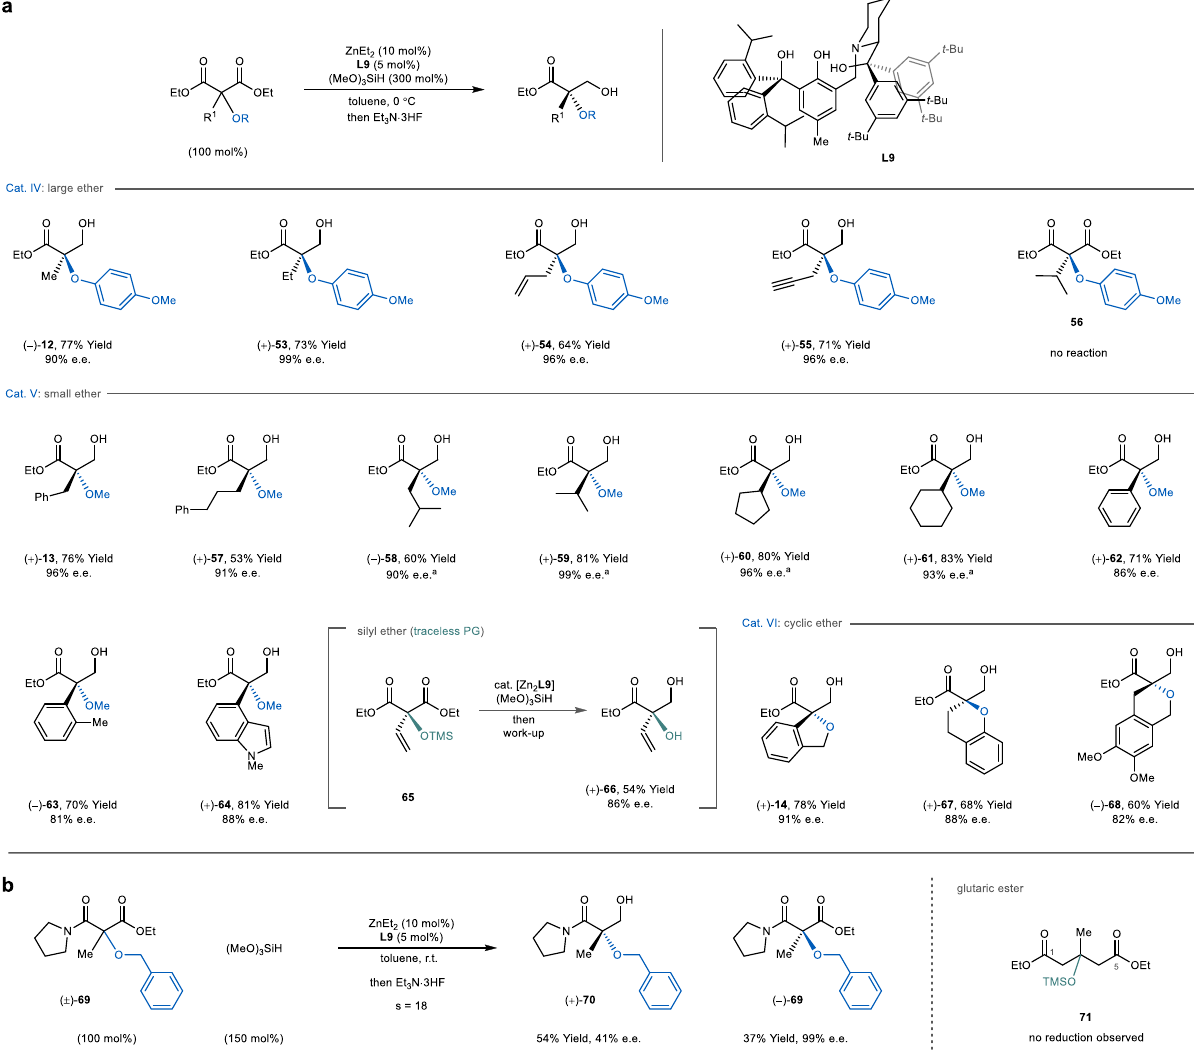
Fig.4|Asymmetrichydrosilylationofoxymalonicesters.a Scopeofoxymalonic esters for the desymmetric hydrosilylation. Unless noted otherwise, the desym- metrizationwasrun usingoxymalonicester(0.3mmol), (MeO) 3 SiH (0.9mmol), L9 (5mol%), and ZnEt 2 (10mol%) in toluene at 0°C. The yields shown were isolated yields and the e.e. values were determined by chiral HPLC analysis of